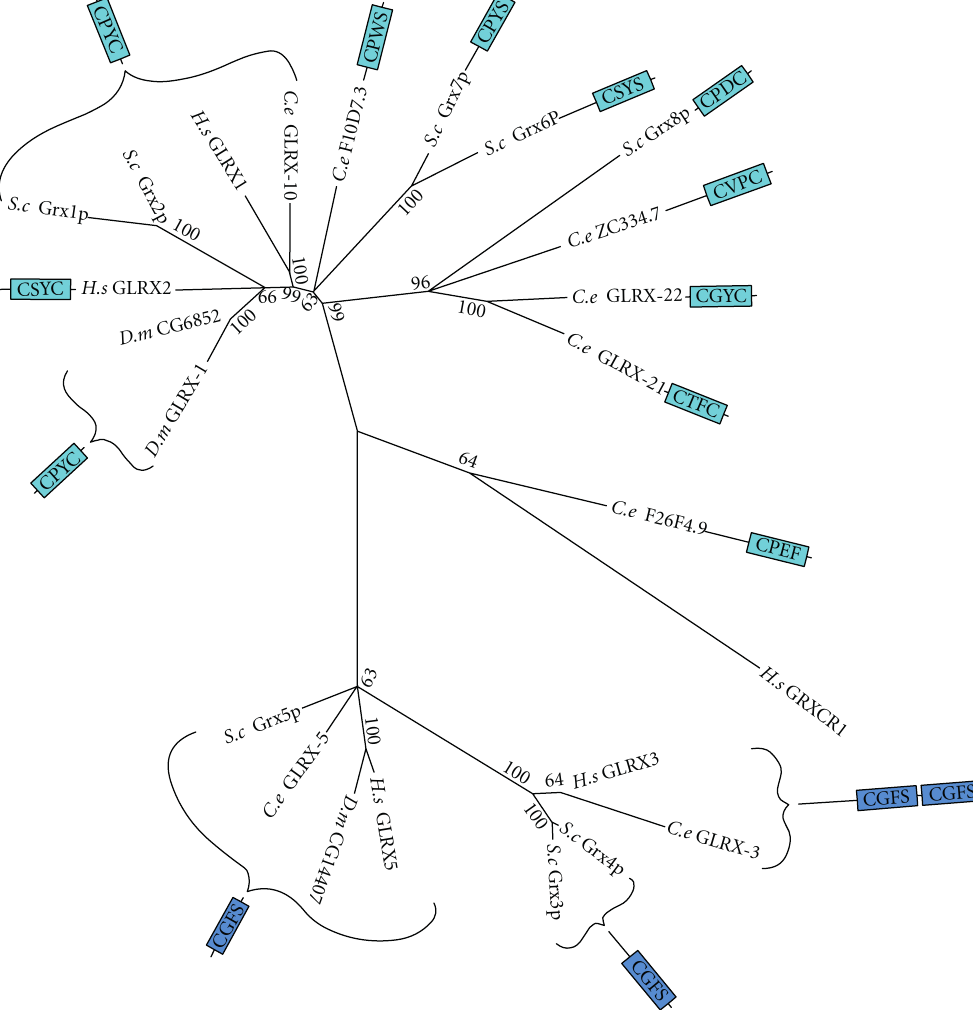
Figure 7: Maximum likelihood majority-rule bootstrap consensus tree of glutaredoxin (GLRX) proteins. Dark blue signifies the conserved active site of monothiol GLRX. Light blue signifies proteins of greater similarity to known dithiol GLRX, regardless of whether or not two cysteines are actually is present in the region aligned to the active sites. See Figure 5 for details of how the sequences were identified and processed as well as how the phylogenetic analysis was carried